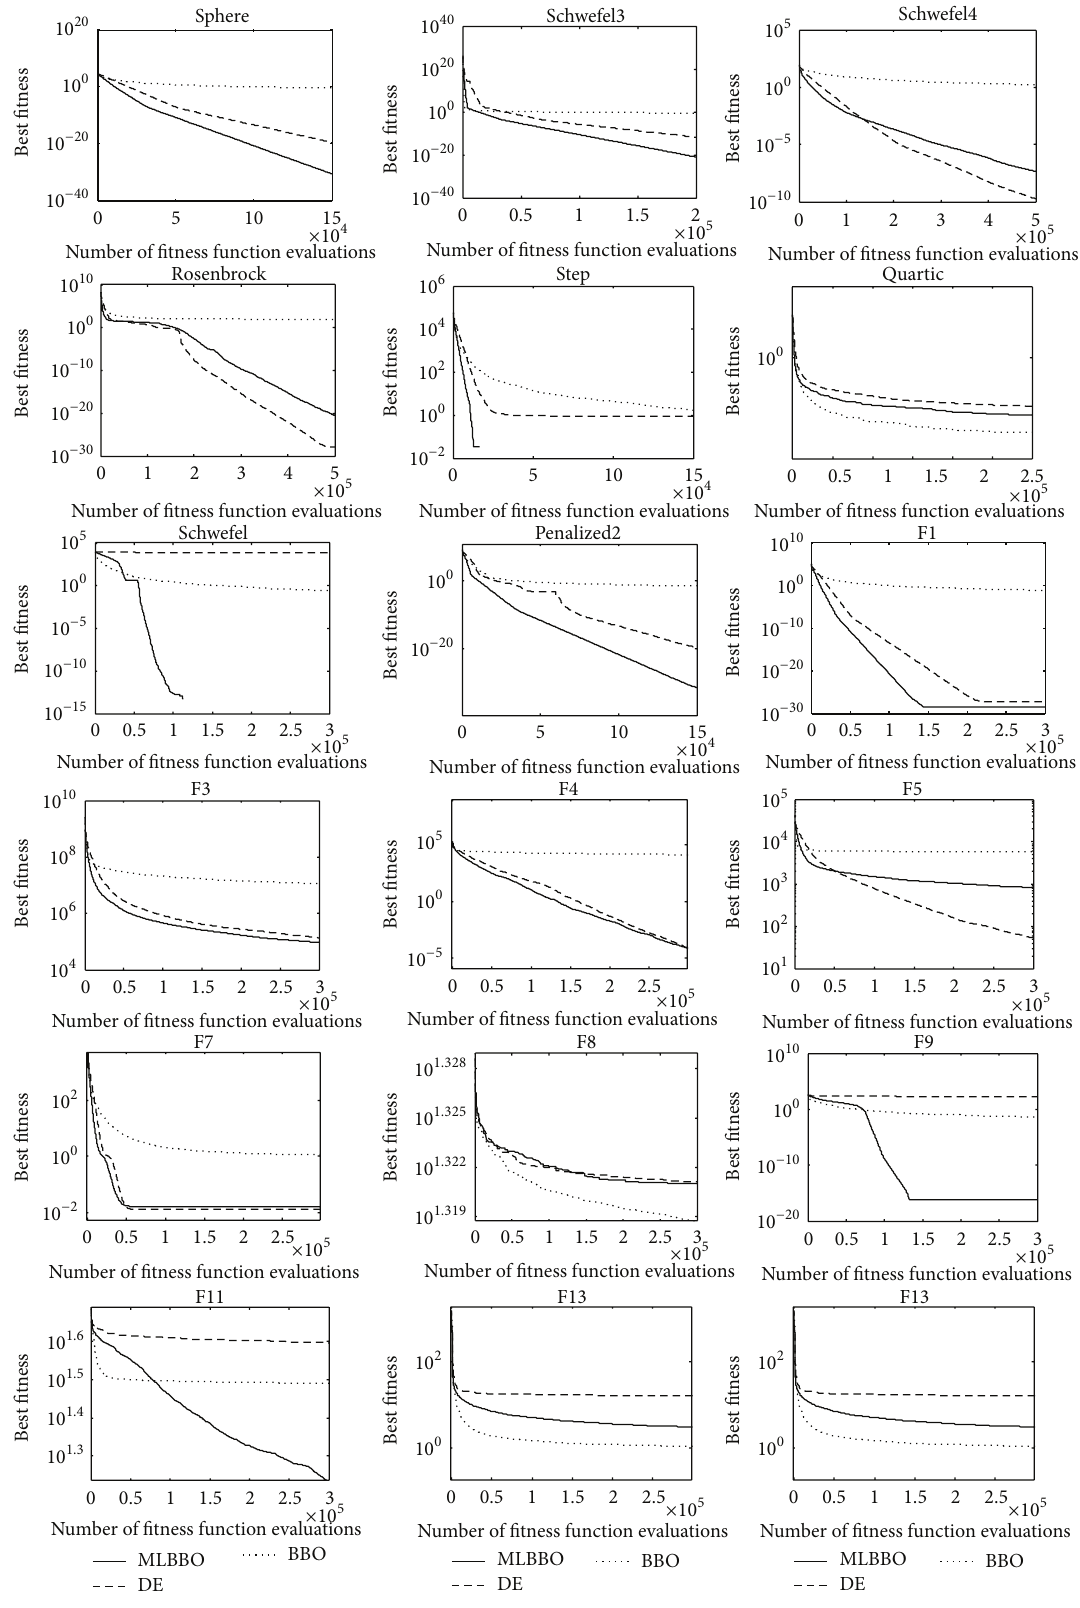
Figure 2: Convergence curves of mean fitness values of MLBBO, BBO, and DE for functions f1, f2, f3, f5, f6, f7, f8, f13, F1, F3, F4, F5, F7, F8, F9, F11, F13, and